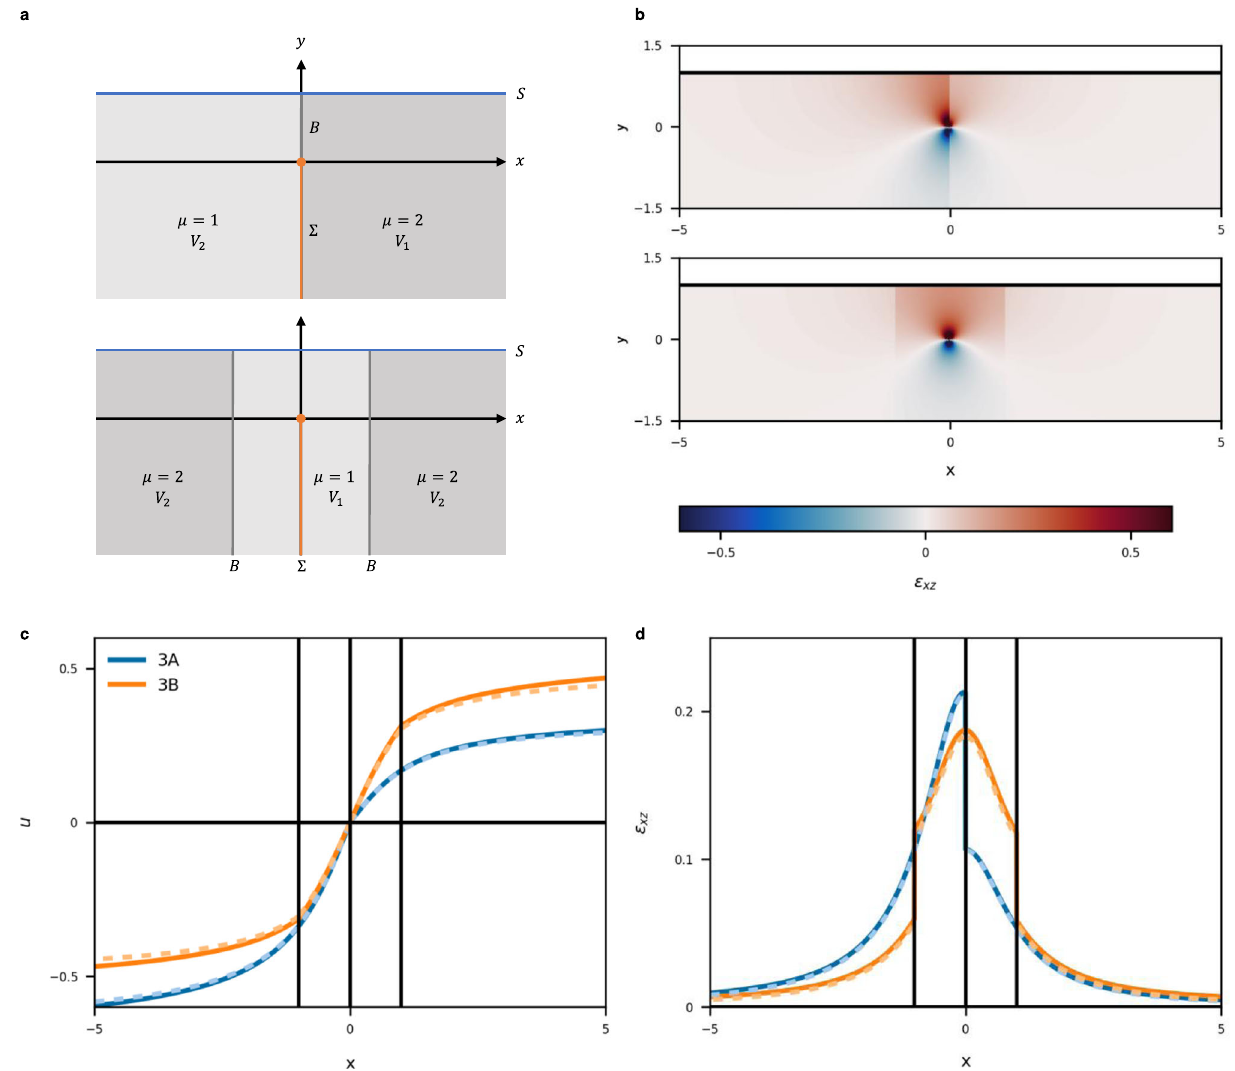
Fig. 4 | Model and estimated results of discontinuous structures. a Model structures of Models 3A (top) and 3B (bottom). Shaded regions represent elastic media V 1 and V 2 ofshearmodulus μ .Theorange,blue,andgraylinesrepresentfault Σ , Earth ’ s surface S , and material boundary B , respectively. b Estimated strains for